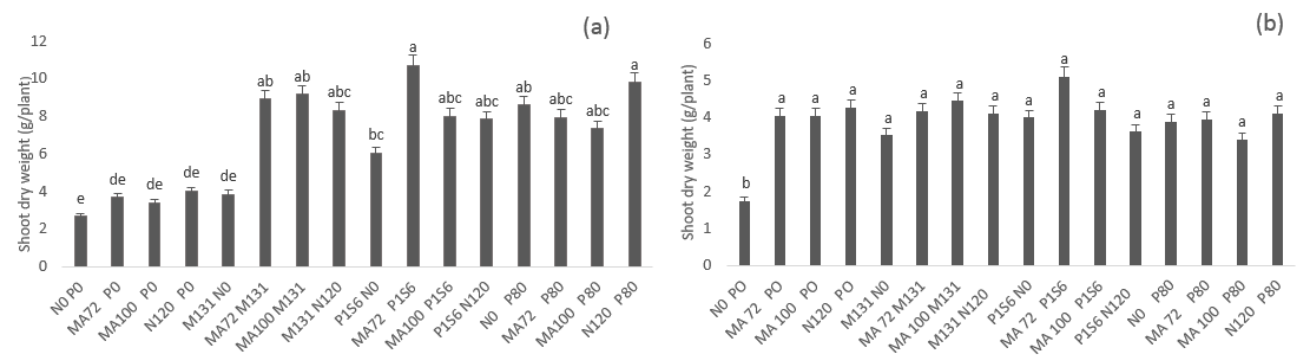
Figure 2. Effect of co-inoculation with Mesorhizobium spp. (MA72 or MA100) and Bacillus sp. (M131) or E. aerogenes (P1S6) and phosphate application combined to rhizobial inoculation on shoot dry weight of chickpea in Merchouch ( a ) and Ain Sbit ( b ) sites. Bars followed by the same letter are not significantly different at α = 0.05. (P80 indicate application of 80 kg P2O5/ha, N120 indicate application of 120 kg N /ha, N0 and P0 indicate no nitrogen and phosphate chemical fertilizers application).